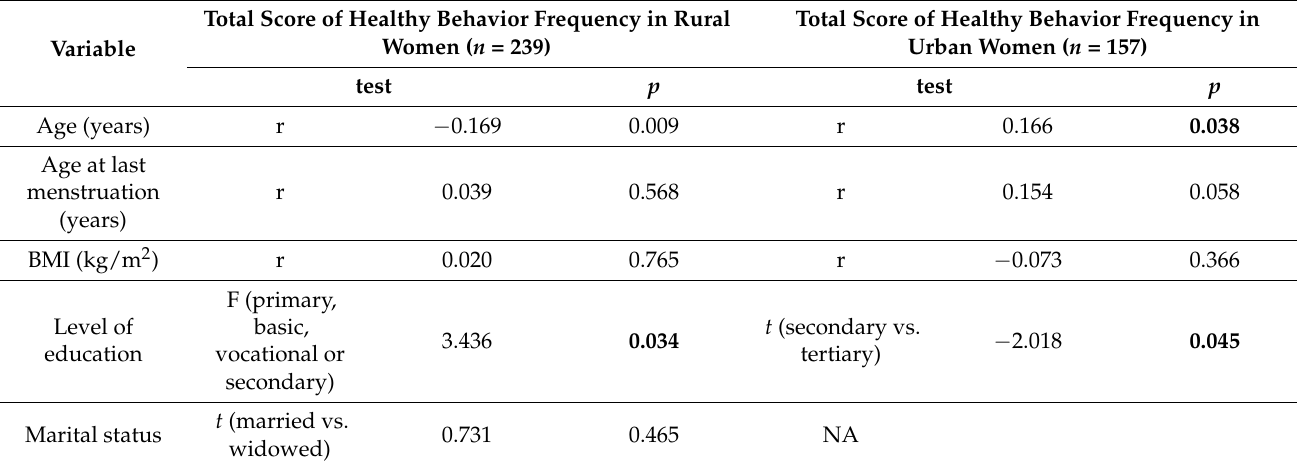
Table 5. Correlations between total score of healthy behavior frequency and study group characteristics.